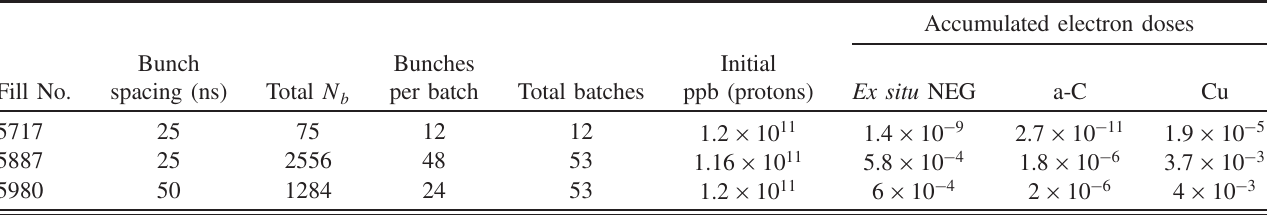
TABLE V. Information related to three fills exploited in this